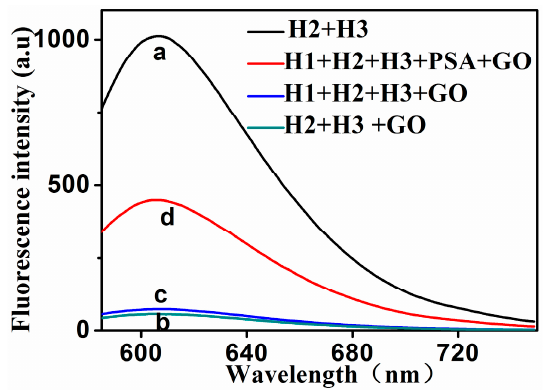
Figure 2. The typical fluorescent emission spectra of different mixtures solution. The mixture solutions, for curves a to d, are: ( a ) H2 + H3; ( b ) H2 + H3 + GO; ( c ) H1 + H2 + H3 + GO; and ( d ) H1 + H2 + H3 + PSA + GO. The concentrations of H1, H2, H3, GO and target (PSA) were 20 nM, 30 nM, 30 nM, 15 µ g · mL − 1 and 5 ng · mL − 1 ,